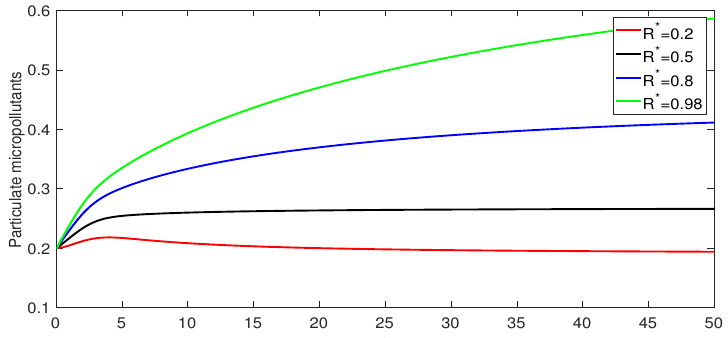
Figure 1. Graphical illustration of the model (8) for δ = 0.8, IBP and various values of recycle ratio.